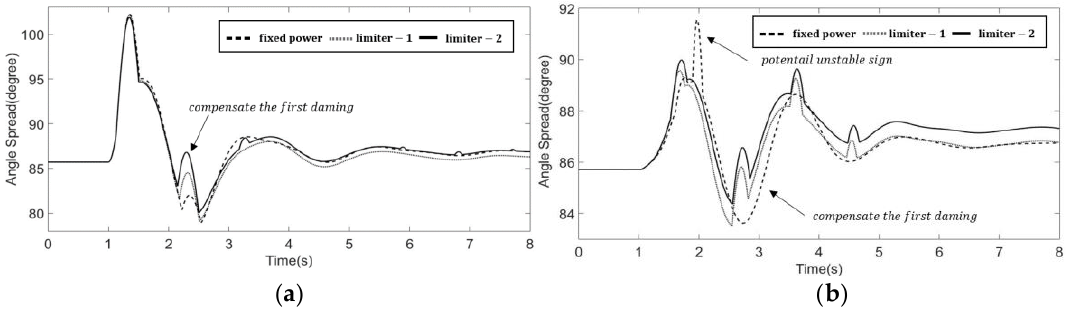
Figure 10. Angle spread of ac grid, ( a ) left side fault ( 𝜃 𝑦 ) , and ( b ) right side fault ( 𝜃 𝑥 ) .